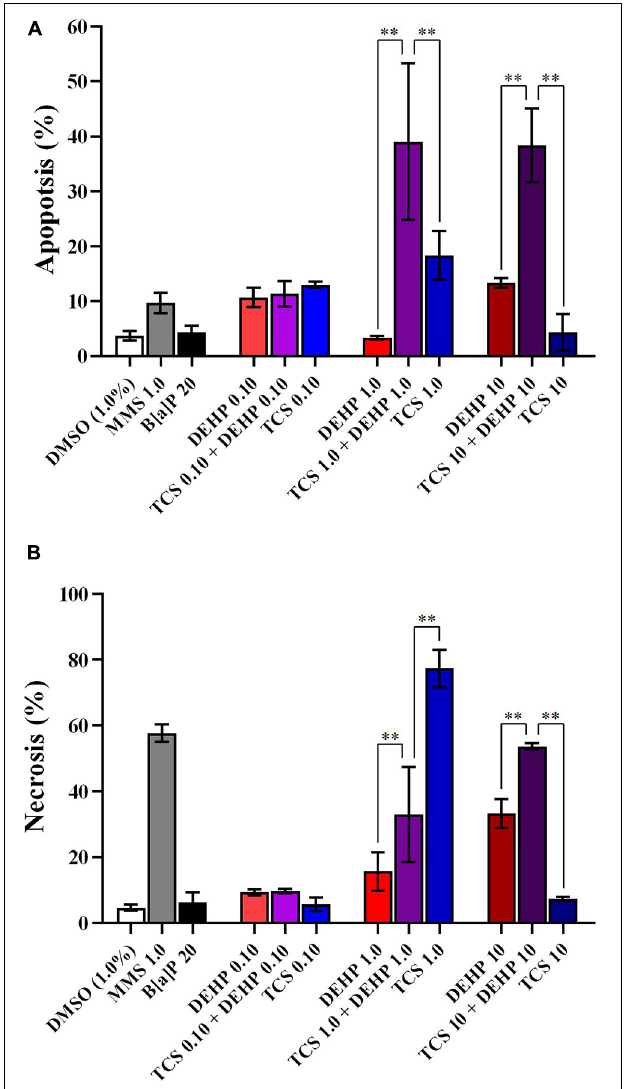
FIGURE 3 | Comparisons between the treatments with TCS + DEHP and their respective groups that receive TCS or DEHP alone, on parameters of cell viability: (A) nuclear division index (NDI) and (B) nuclear division cytotoxicity index (NDCI). All doses are in µ M. ∗ p < 0.050; ∗∗ p < 0.010; Wald’s chi-square tests followed by Bonferroni correction